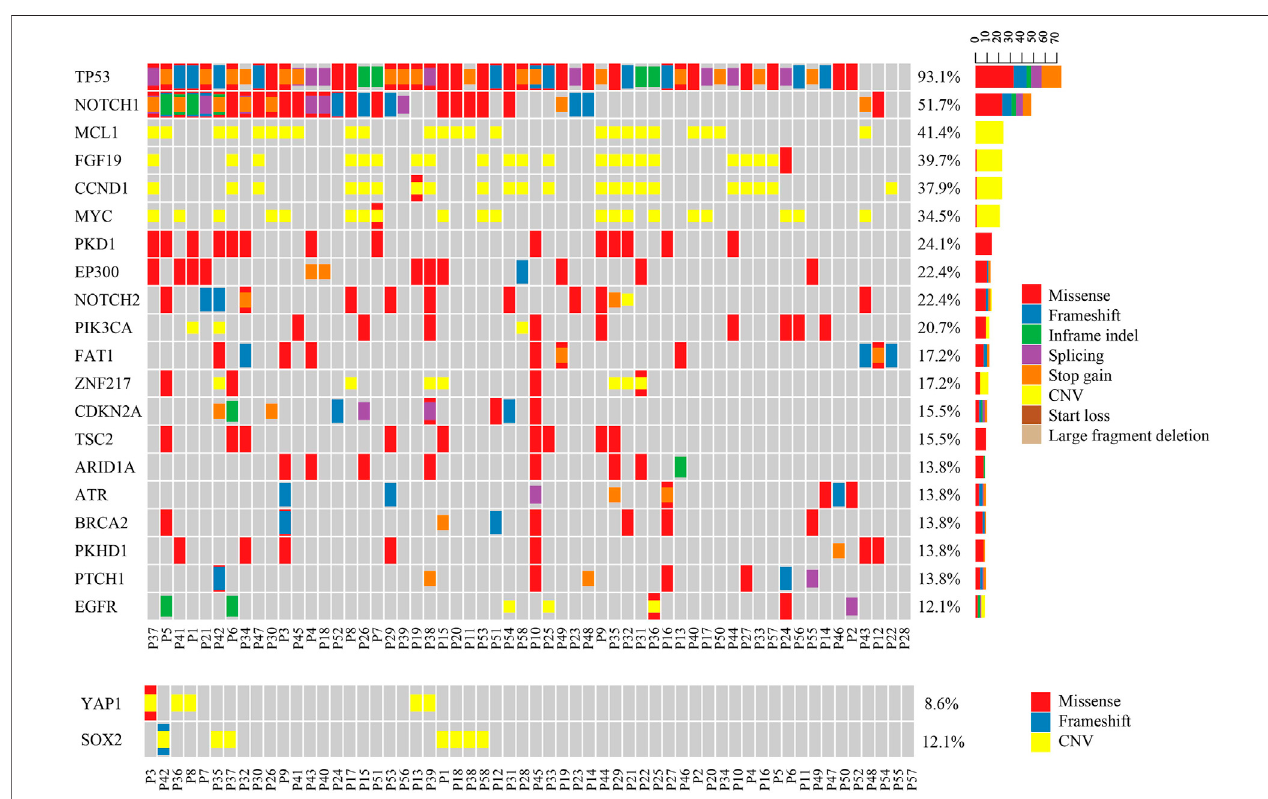
FIGURE1| MutationalpatterninChineseESCCpatients.Theupperoncoplotshowsthemutationallandscapeofpatientsinthiscohort.Theloweroncoplotshows that YAP1 gain and SOX2 gain are mutually exclusive to each other. No patient had both ampli fi cations at the same time.